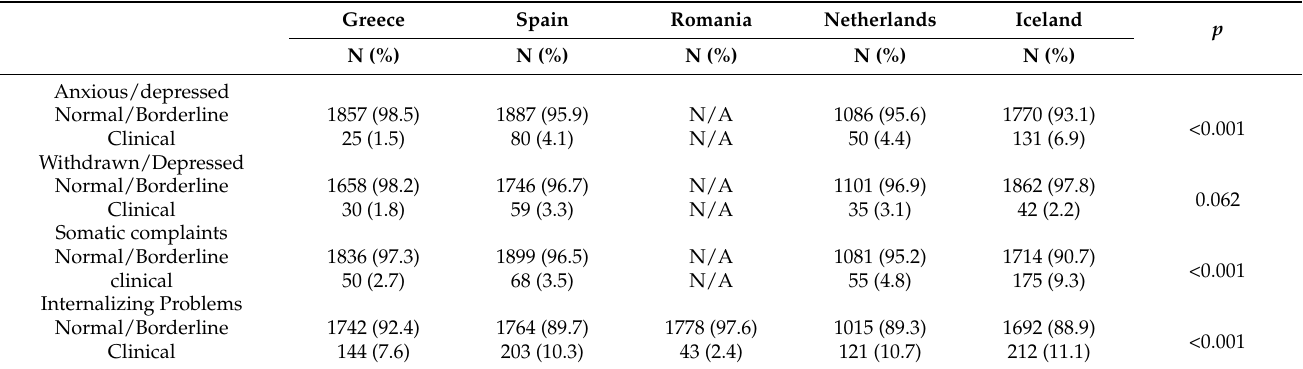
Table 2. Proportion of adolescents being at clinical range (>98th percentile) of internalizing problems by